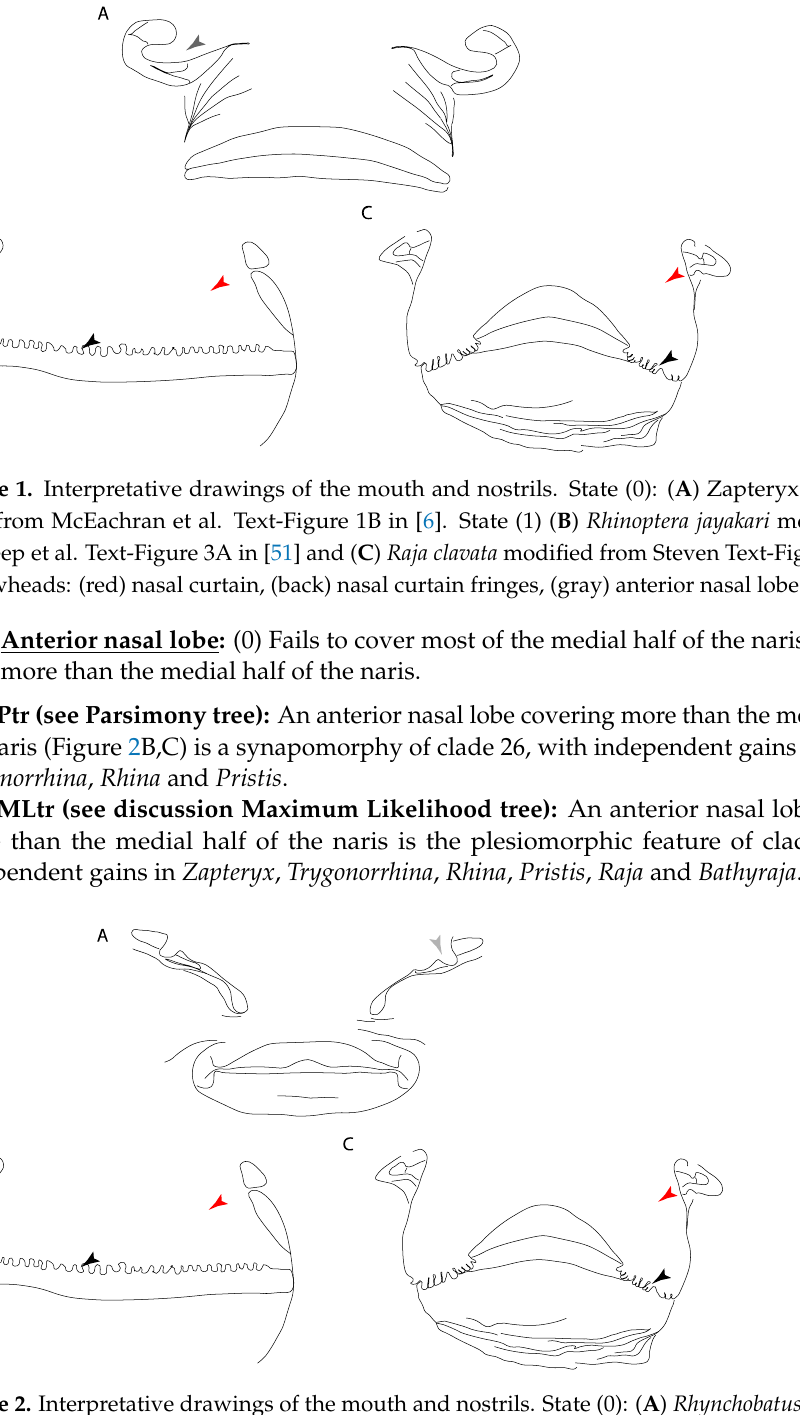
Figure 2. Interpretative drawings of the mouth and nostrils. State (0): ( A ) Rhynchobatus immaculatus redrawed from Last et al. Text-Figure 6 in [53]. State (1) ( B ) Rhinoptera jayakari redrawn from Pradeep et al. Text-Figure 3A in [51] and ( C ) Raja clavata redrawn and modified from Steven Text-Figure 8 in [52]. Arrowheads: (red) nasal curtain, (back) nasal curtain fringes, (gray) anterior nasal lobe. 33. Nasal curtain fringes: (0) Absent; (1) present